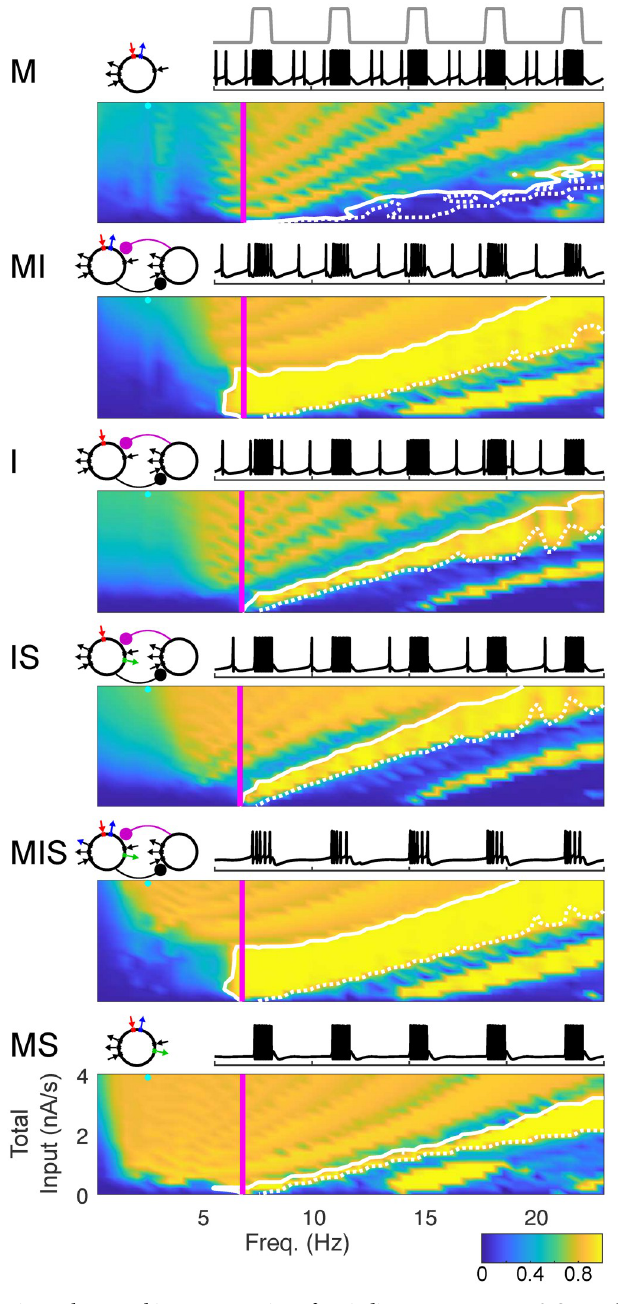
Fig 3. Phase-Locking as a Function of Periodic Input Frequency & Strength. False-color images show the (spike- rate adjusted) phase-locking value (PLV, see Section 4.3) of spiking to input waveform. Vertical magenta lines indicating intrinsic spiking frequency. Solid white contour indicates boundary of phase-locking with one spike per cycle; dotted white contour indicates boundary of phase-locking with 0.9 spikes per cycle. Bands in false-color images of PLV are related to the number of spikes generated per input cycle: the highest PLV occurs when an oscillator produces one spike per input cycle, and PLV decreases slightly (from band to band) as both the strength of the input and the number of spikes per input cycle increases. Schematics of each model appear above and to the left; sample traces of each model appear above and to the right (voltage traces in black, input profile in gray, two seconds shown, input frequency 2.5 Hz, total input − 3.4 nA/s, as indicated by cyan dot on the false-color image). Total input per second was calculated by integrating input over the entire simulation.